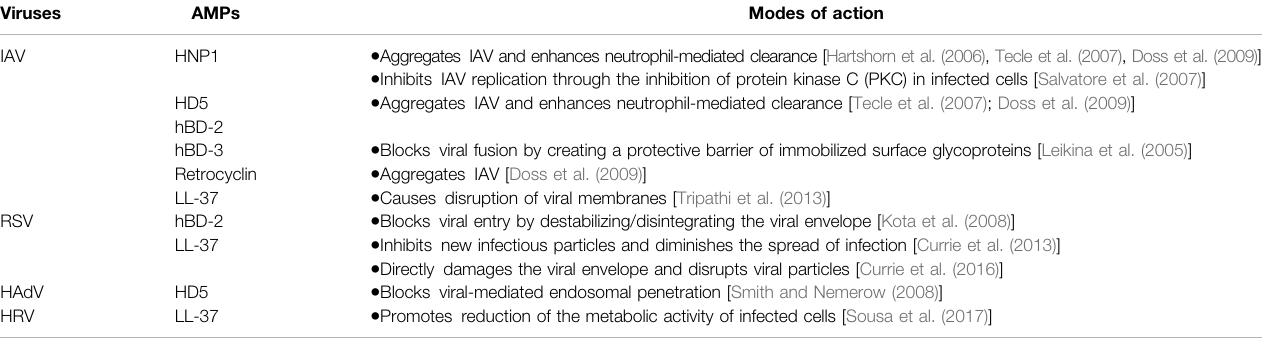
TABLE 1 | Modes of action of defensins and LL-37 against respiratory viruses.